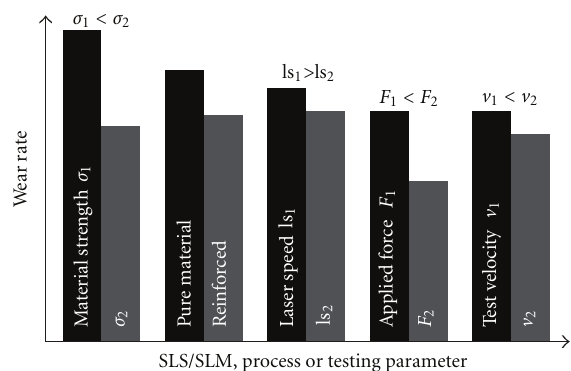
Figure 5: Qualitative impact of several SLS/SLM process and testing parameters on the resulting wear rate.